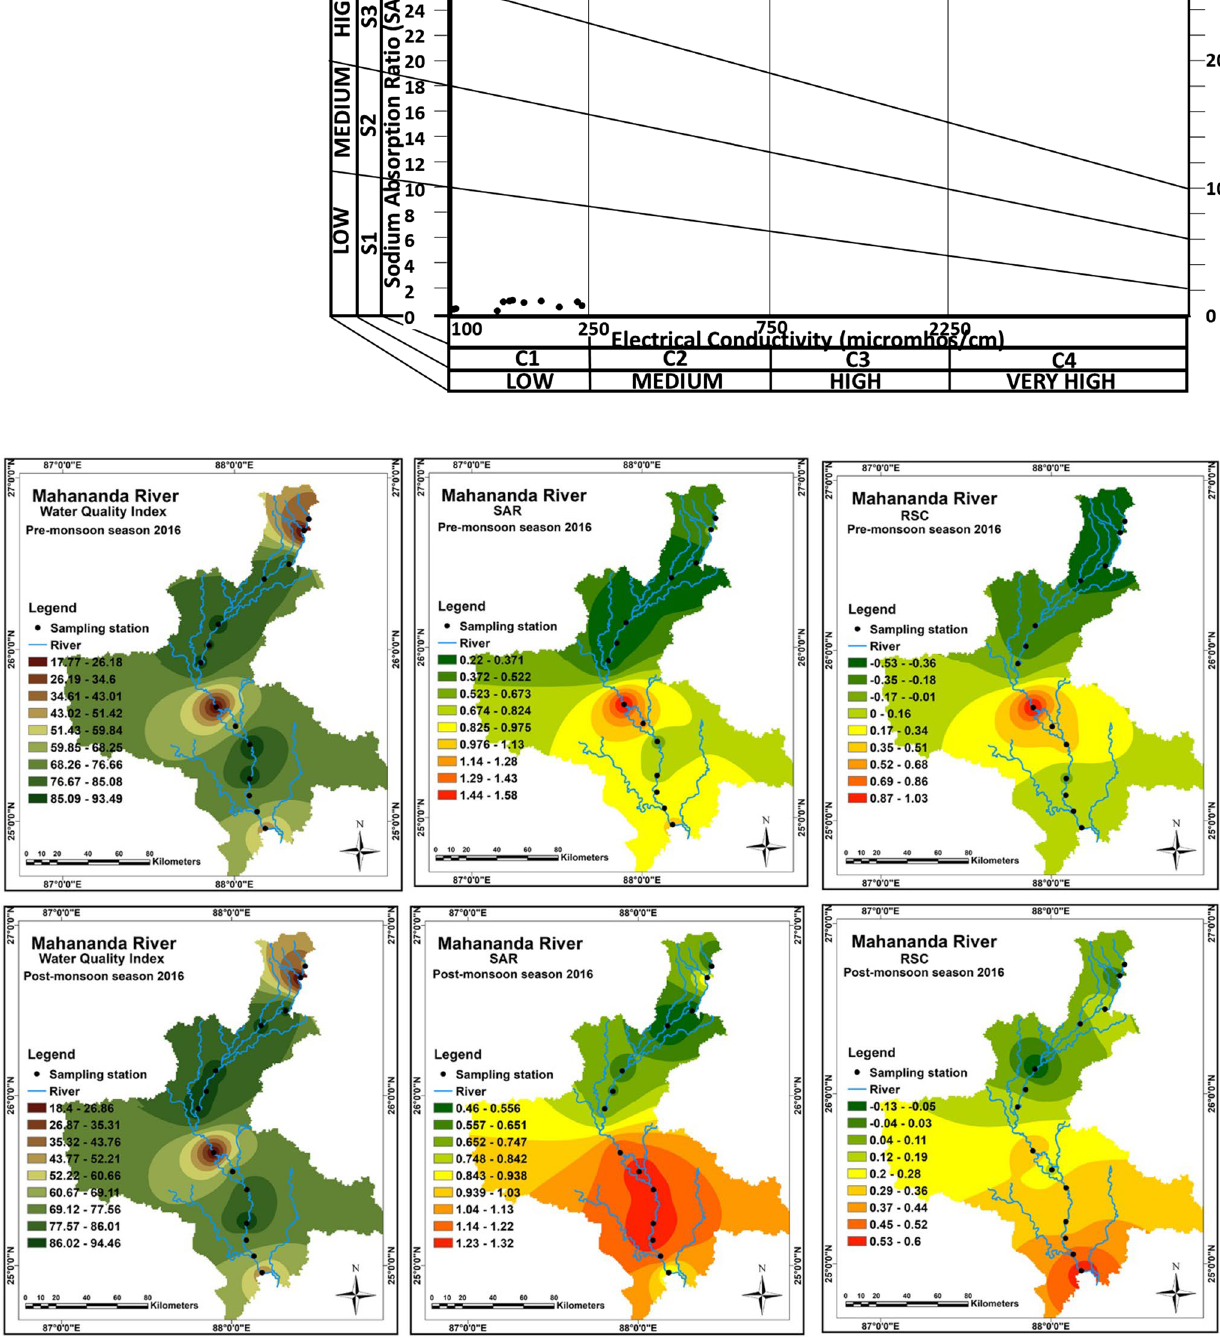
Fig. 10 Spatial variations of water quality index (WQI), sodium adsorption ratio (SAR) and residual sodium carbonate